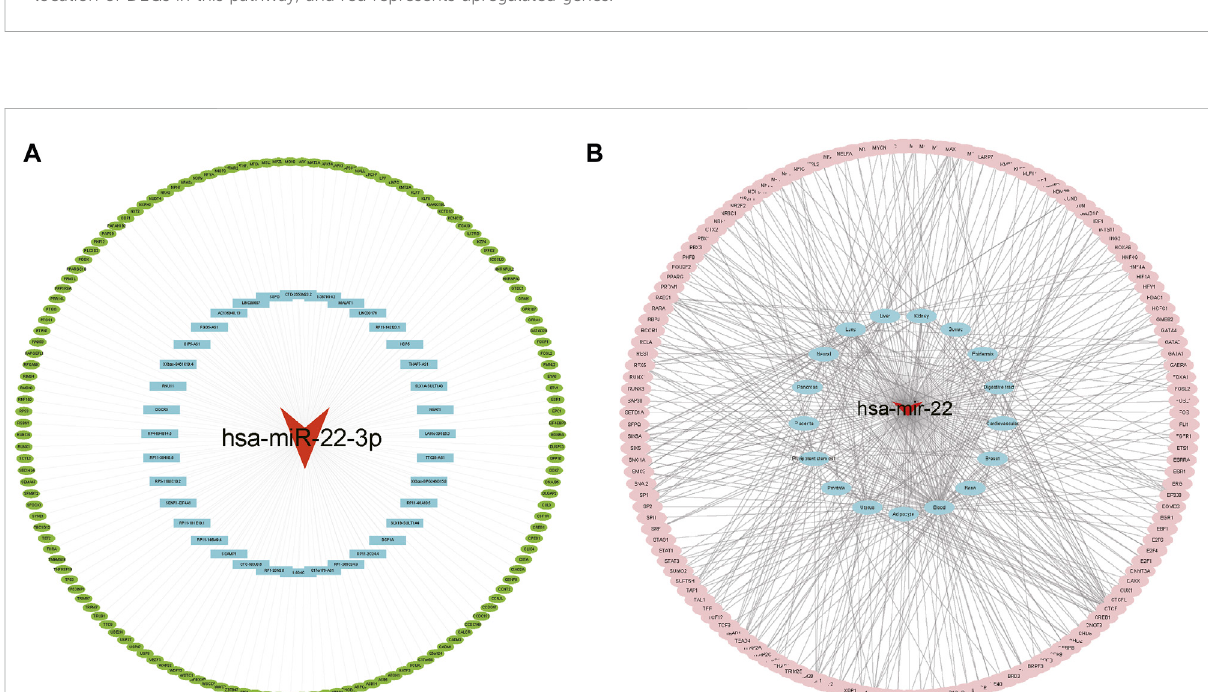
FIGURE 4 Pathview analysis of DEGs. (A) Pathview pathway map of the HIPPO signaling pathway. (B) Prion disease pathway map. Colors represent the location of DEGs in this pathway, and red represents upregulated genes.